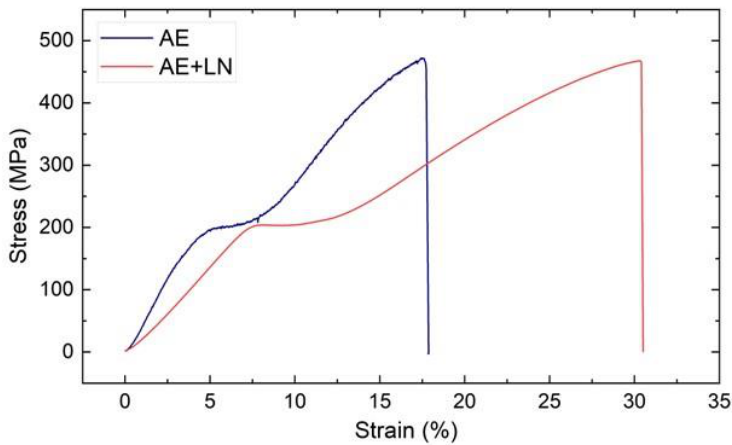
Figure 4. Compressive stress–strain curves of samples with and without DCT. Table 5. Results of compressive testing